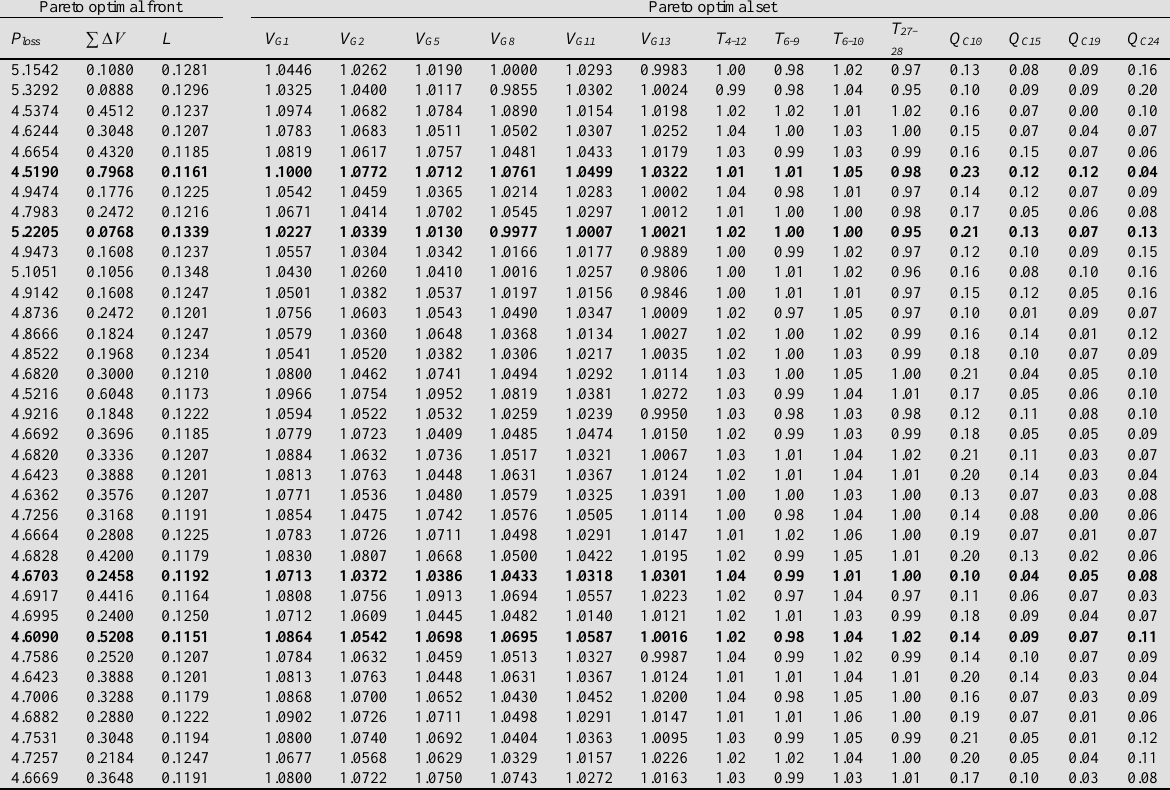
Table 3.The results of IEEE 30-bus test system Pareto optimal front Pareto optimal set